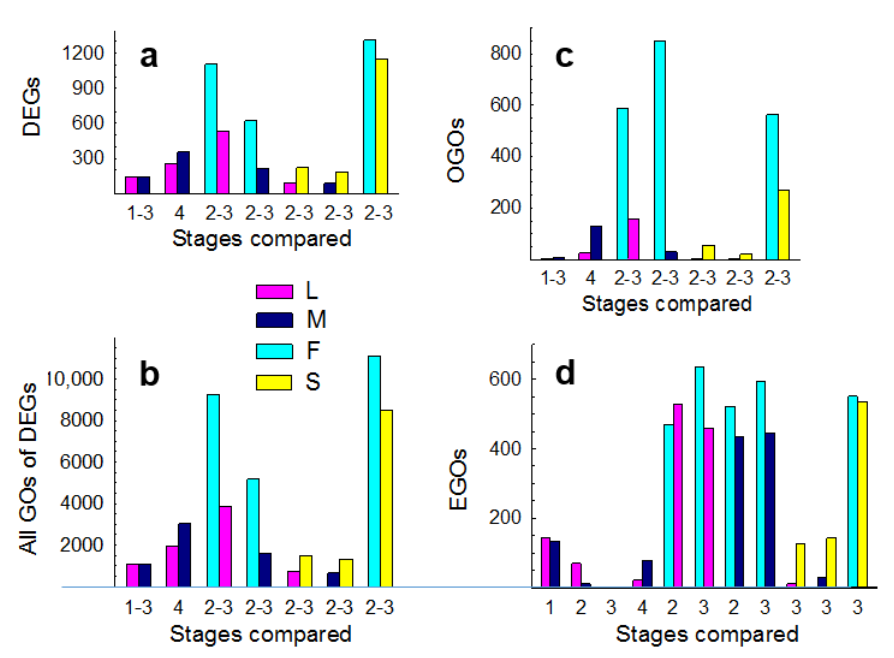
Figure 1. Di ff erentially expressed genes (DEGs) and associated gene ontology categories (GOs) by comparison: ( a ) DEGs, ( b ) all GOs of all DEGs, ( c ) overrepresented GOs (OGOs), ( d ) enriched GOs (EGOs). L ( Boechera lignifera ), M ( Boechera microphylla ), F ( Boechera × formosa ), S ( Boechera stricta ), 1 (megasporocyte (MMC) stage), 2 (active meiocyte stage), 3 (young gametophyte stage), 4 (mature gametophyte stage).